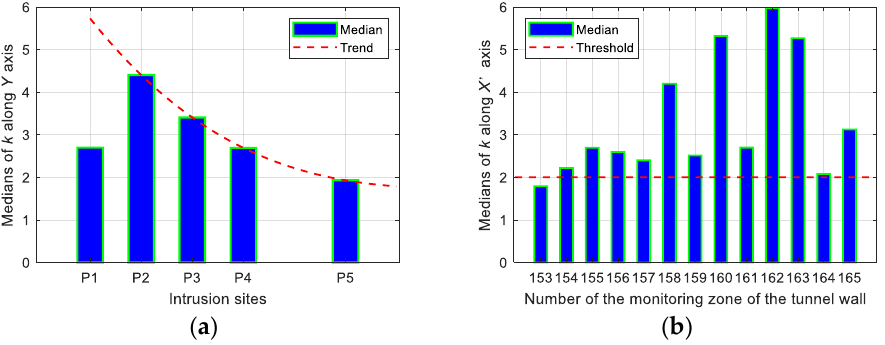
Figure 16. Median distributions along ( a ) the intrusion site and ( b ) the monitoring zone.